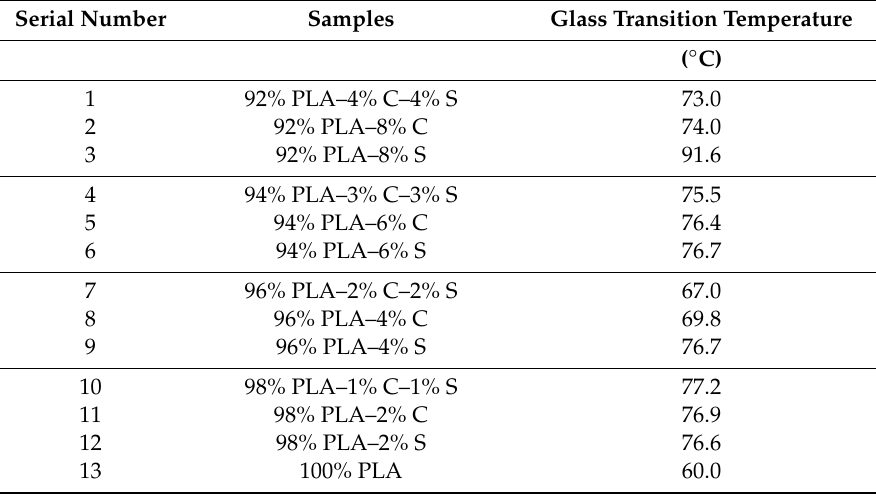
Table 4. Glass transition temperature for the samples.